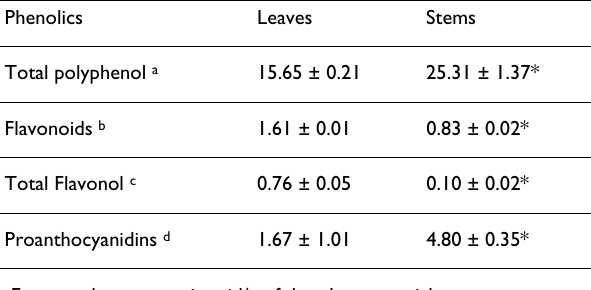
Table 2: Polyphenol contents of the methanol extracts of the leaves and stems of Buddleja saligna (n = 3, X ± SEM). Phenolics